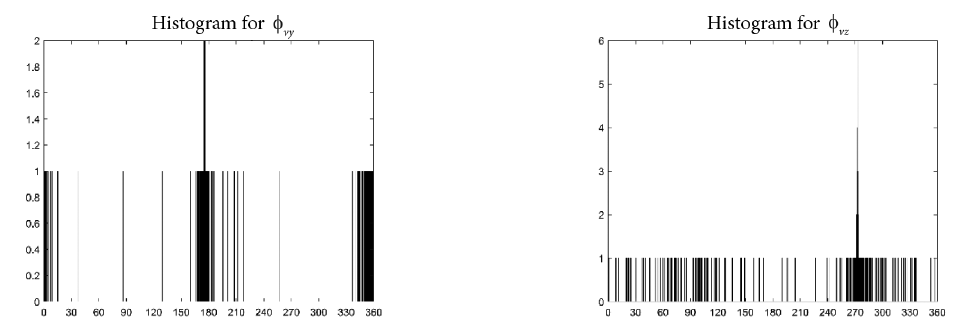
Figure 11. Histograms for angle coordinates of two orthogonal VPs for